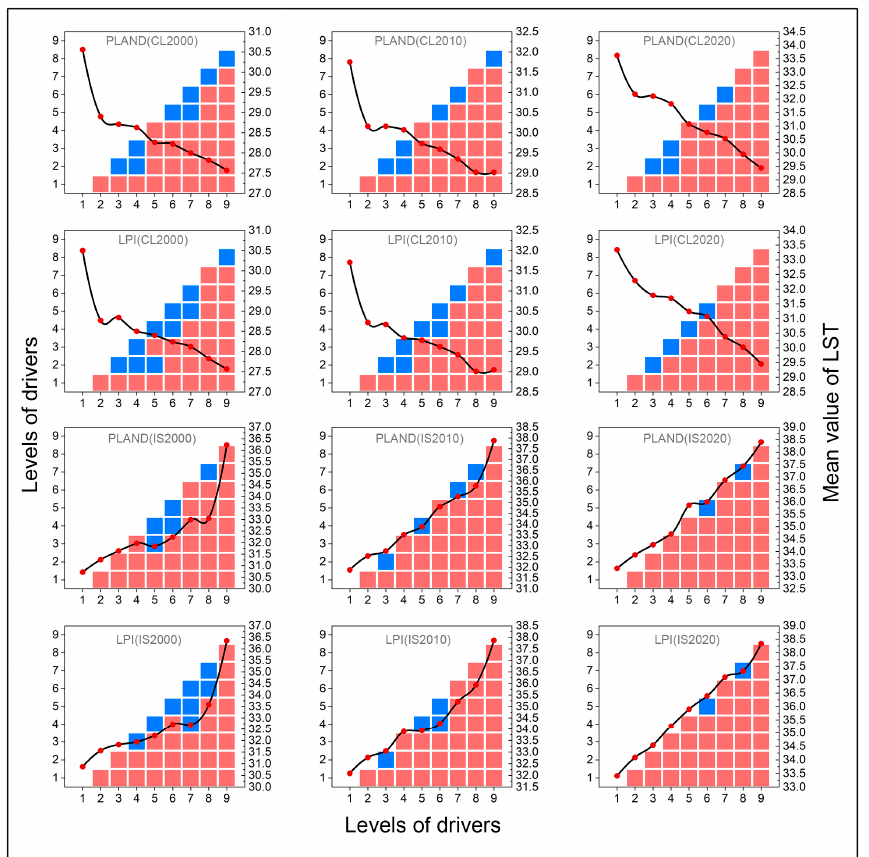
Figure 9. Results of the class-level risk detector. (Curves represent the change in the mean LST at various levels for each driver. Red squares denote that the di ff erence in e ff ect on LST between the two factor levels is signi fi cant with 95% con fi dence. Blue squares denote insigni fi cance.). In the landscape-level risk detection analysis, the relationship between di ff erent driv- ers and LST di ff ers signi fi cantly (Figure 10). The NDBI, population density and nigh tt ime light were positively correlated with LST, which means that the development of construc- tion land, the growth of the population and the increase in the socioeconomic level will increase LST. Compared to the NDBI, population density and nigh tt ime light, FVC had a near-linear negative association with LST. For FRAC_AM, LST always decreased rapidly in the fi rst two levels and showed a constant negative correlation in the subsequent levels. In addition, the MNDWI was found to show a signi fi cant nonlinear association with LST. LST increased rapidly with increasing levels of MNDWI, peaking between levels 7 and 8. At subsequent levels, LST decreased rapidly.